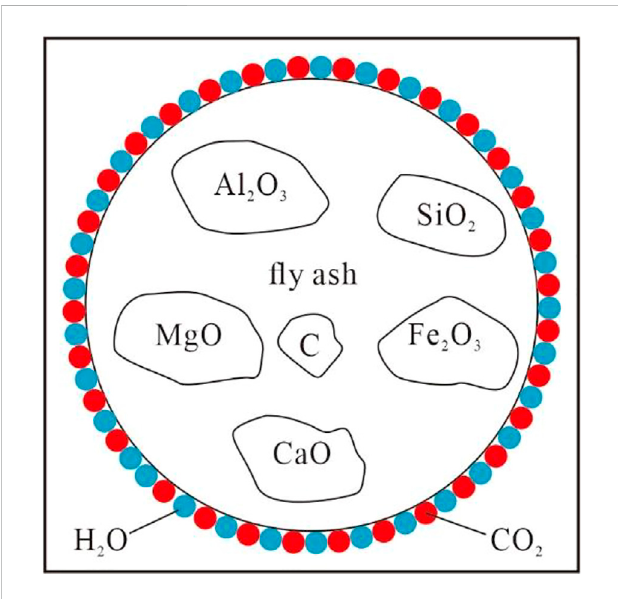
FIGURE 6 Schematic diagram of the CO 2 reaction with alkaline oxides.